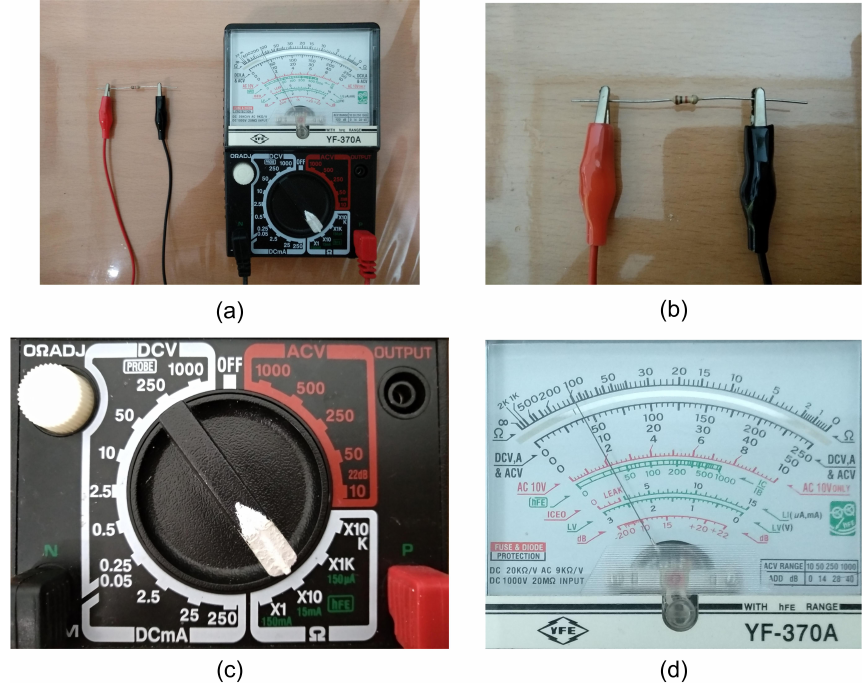
Figure 1. ( a ) Illustration of people using the A-meter (model YF-370A) to measure a 1 K Ω resistor. ( b ) The measured resistor can be identified by the four-band of colors (brown-black-red-gold) which represents 10 × 10 2 ± 5% ( Ω ) [2]. Note that ( c ) the selector arrow of the function selector is switched to the location of × 10 and ( d ) the pointer in the instrument meter indicates around 100 by observing the nonlinear Ω